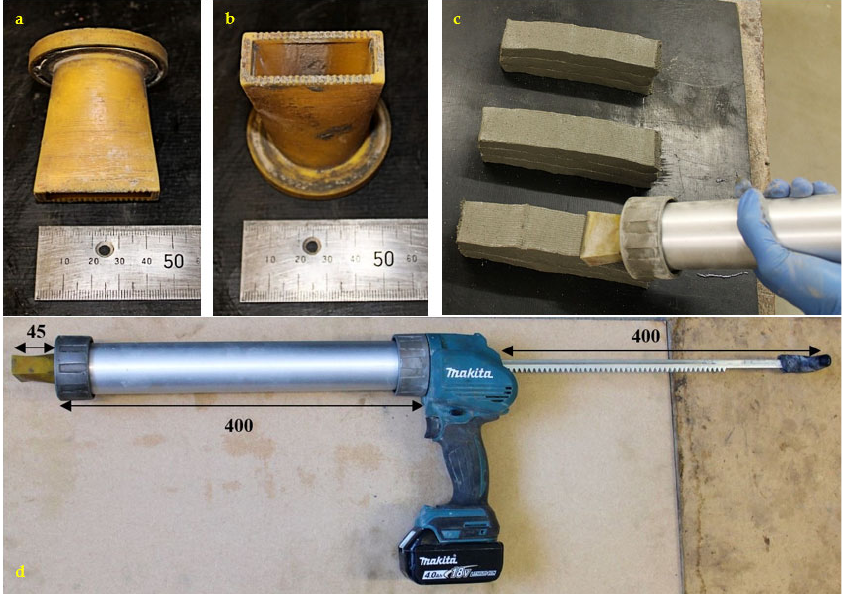
Figure 2. The printing system used for printing of mortar (all dimensions are in mm): ( a ) side view of the nozzle, ( b ) front view of nozzle, ( c ) battery operated ram extruder device fitted with nozzle, and ( d ) a few printed sample later used for flexural strength test of extruded samples.